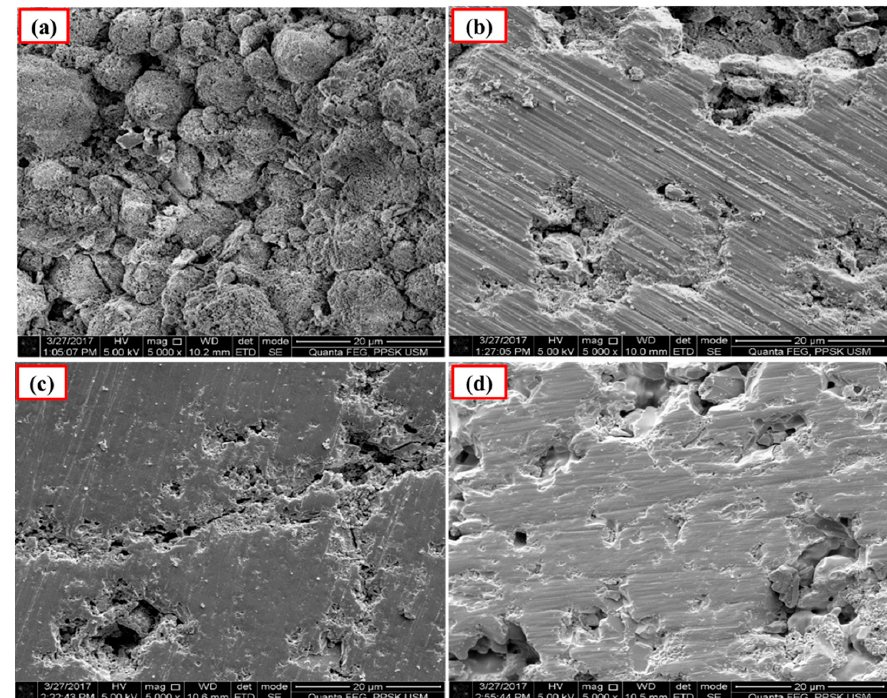
Figure 6. SEM images of polished Ca-SZ(CS) sintered for 2 h at ( a ) 1200 °C; ( b ) 1300 °C; ( c ) 1400 °C and ( d ) 1500 °C.